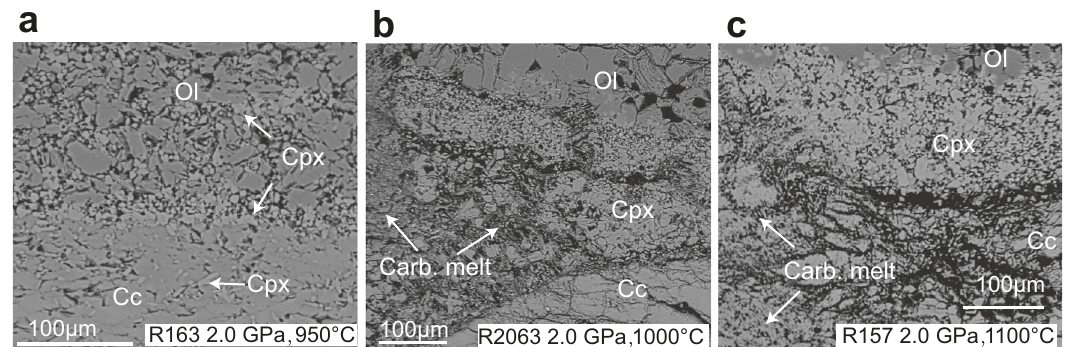
Fig. 2 Representative backscattered electron images of experimental charges. a Subsolidus and b , c above-solidus temperatures at 2.0 GPa. Ol olivine, Cc calcite, Cpx clinopyroxene, Carb.melt carbonatite melt.